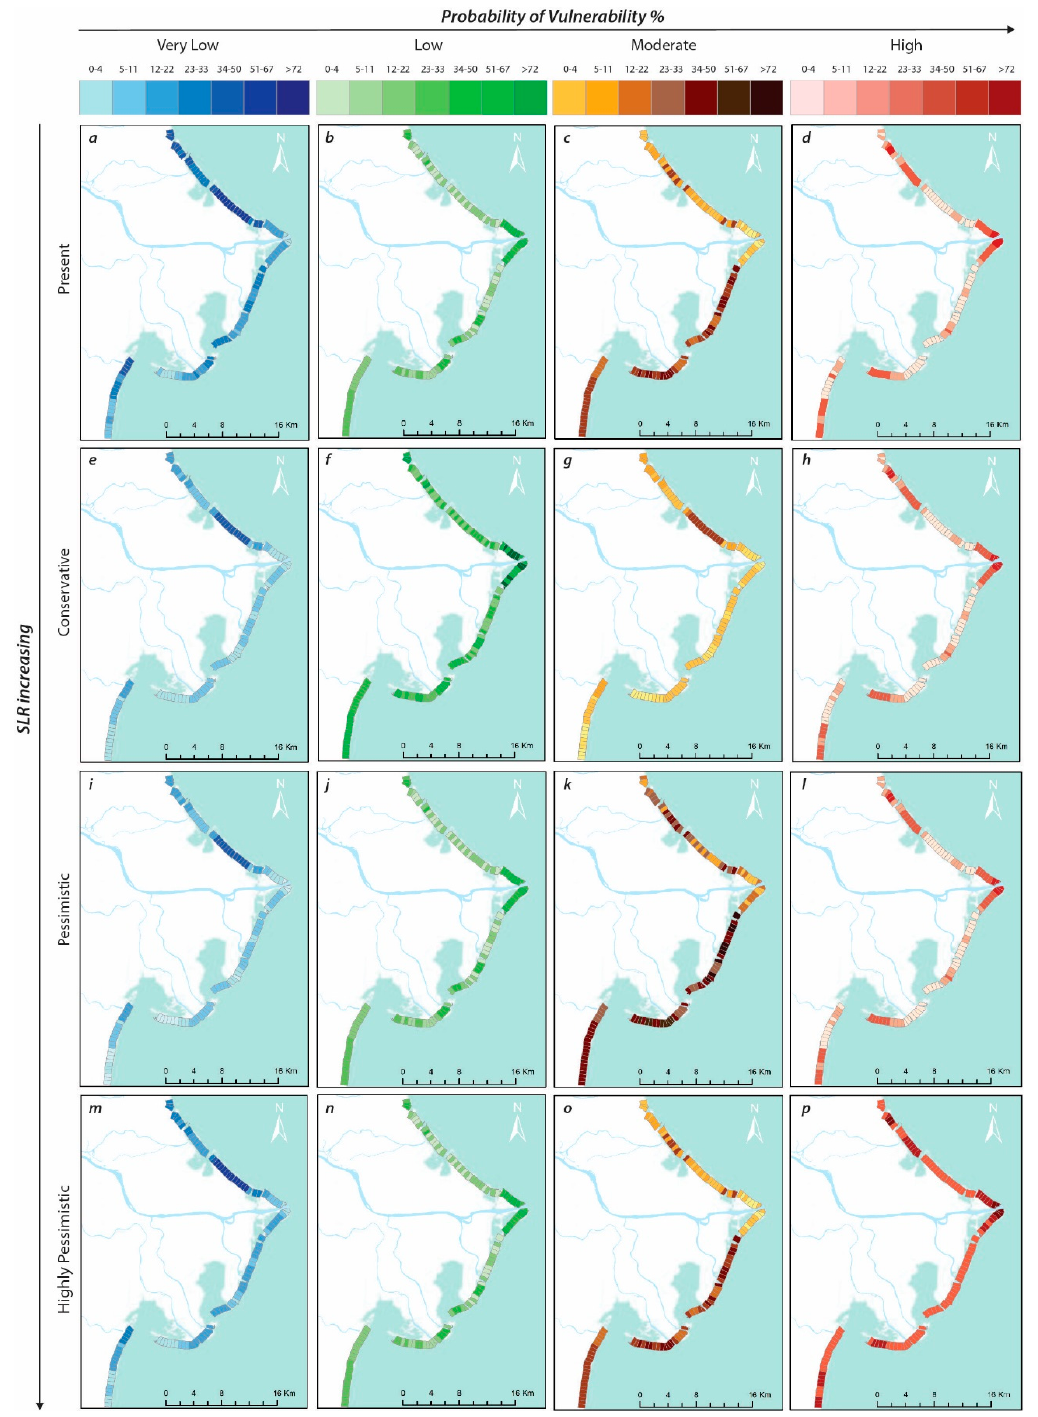
Figure 9. Vulnerability probability map at cell spatial scale considering SLR increasing. The color palette is divided into four color groups corresponding to the vulnerability target classes from very low (blue), low (green), moderate (yellow), and high (red). Each vulnerability target class is divided in seven classes of increasing probability score from lighter to darker hues.